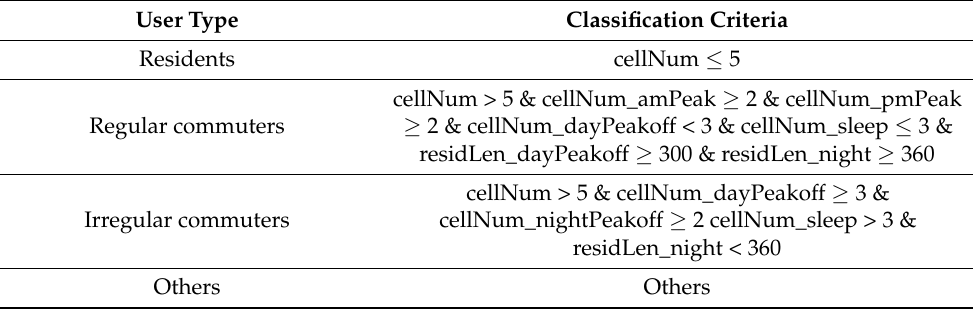
Table 3. Classification criteria of each user